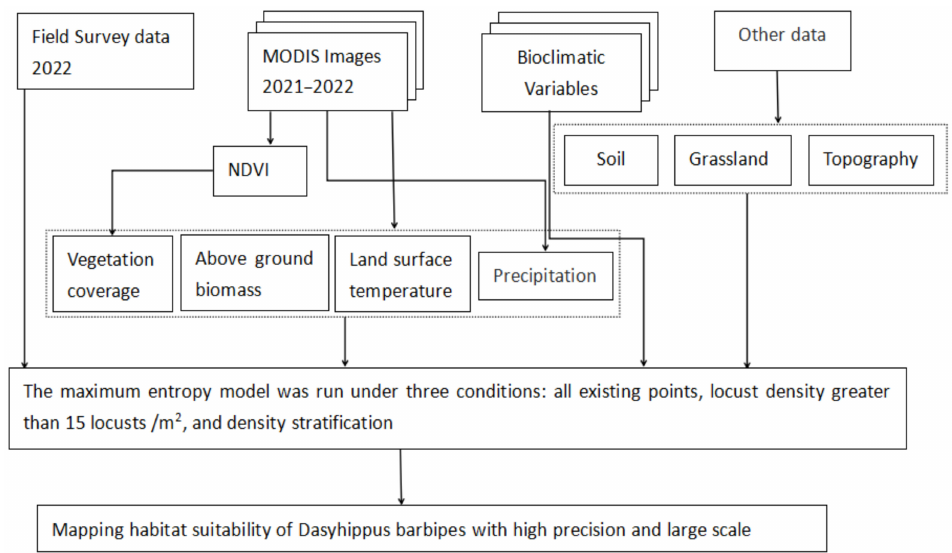
Figure 2. A flowchart of the research